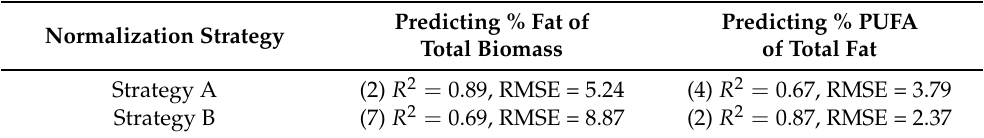
Table 1. Results from PLSR on the spectra shown in Figure 2. Models for predicting total % fat of the total biomass, as well as % PUFA of the total amount of fat was established. Every instance in the table starts with ( A opt ), which was found based on the full cross-validation on the training set. For the test set, the % fat range from 19.7 to 87.1, with an average of 41.4 and standard deviation at 16.0. The % PUFA values range from 8.68 to 41.3, with an average of 23.5 and standard deviation at 6.64. Normalization